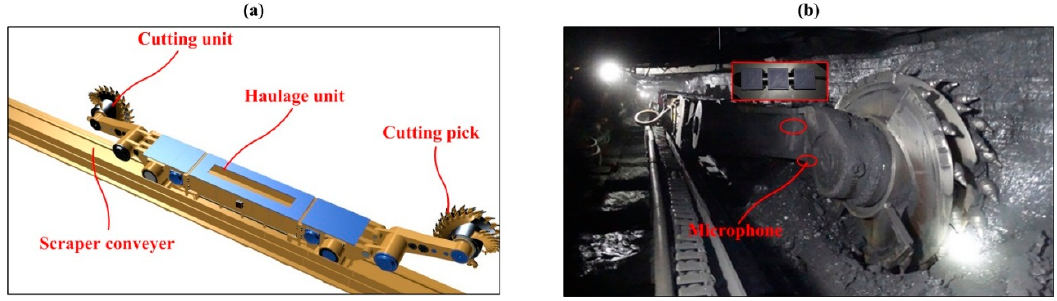
Figure 10. ( a ) Three ‐ dimensional model of the shearer; and ( b ) collection of field cutting sound.